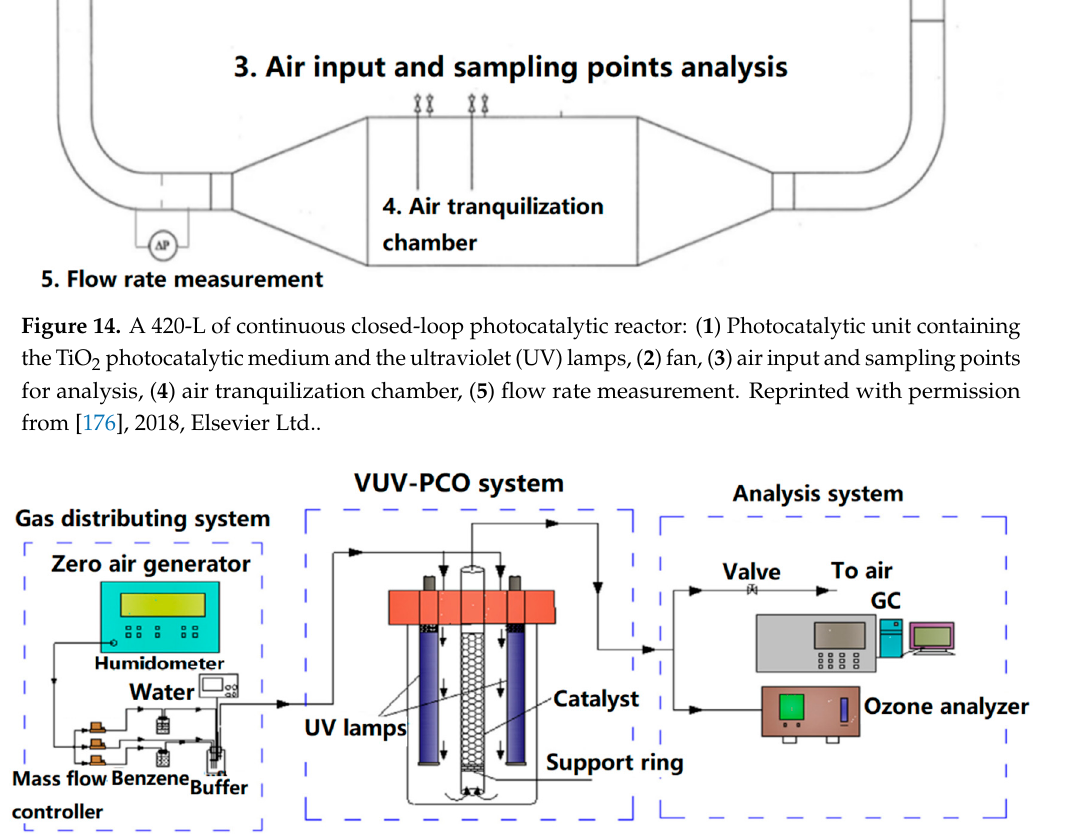
Figure 15. The schematic diagram of the VUV ‐ PCO system. Reprinted with permission from [63], 2017, Elsevier Ltd.